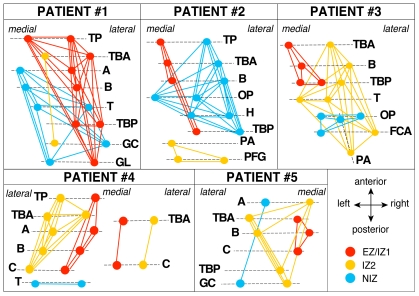
Interactions between regions of interest recorded from depth electrodes.Red circles: ROIs are in the epileptogenic/primary irritative zone (EZ/IZ1); Orange circles: ROIs are in secondary irritative zone (IZ2); Blue circles: ROIs are in non irritative zone (NIZ). Lines correspond to the links for which connectivity was evaluated. Electrodes names correspond to each brain structure recorded by the electrode. TP: temporal pole; TBA: entorhinal cortex; A: amygdala; B: anterior hippocampus; T: thalamus; TBP: fusiform gyrus, GC: posterior cingulate gyrus; GL: lingual gyrus; OP: insula; H: Heschl gyrus; PA: precuneus; PFG: posterior cingulate gyrus; FCA: anterior calcarine fissure; C: posterior hippocampus.